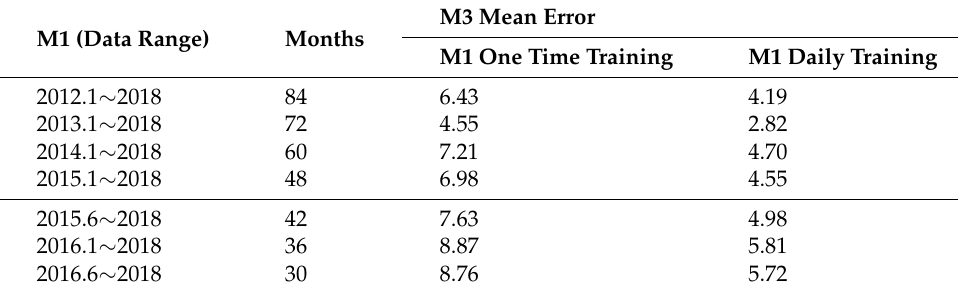
Table 2. Comparison between one time and daily training.